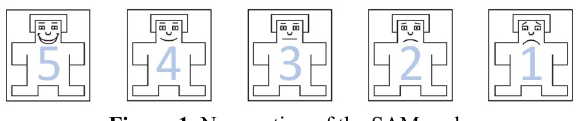
Figure 1. Numeration of the SAM